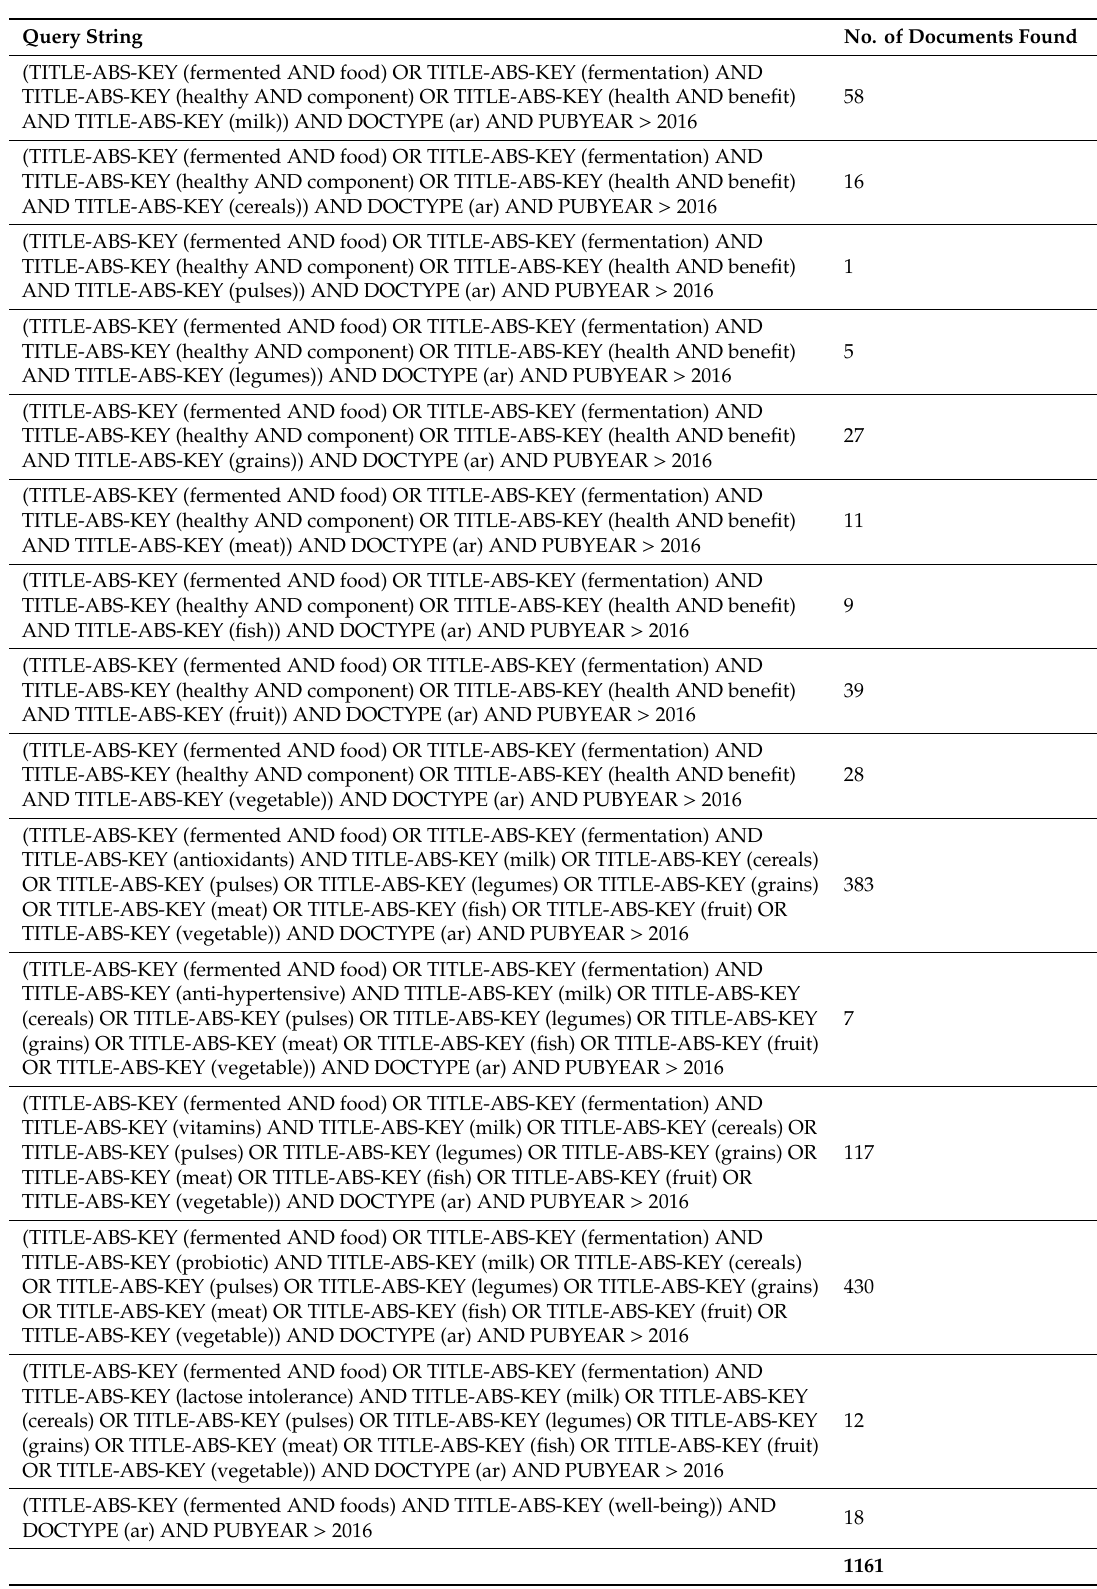
Table 1. Query strings used for the database search on Elsevier’s SCOPUS, the largest bibliographic database of peer-reviewed